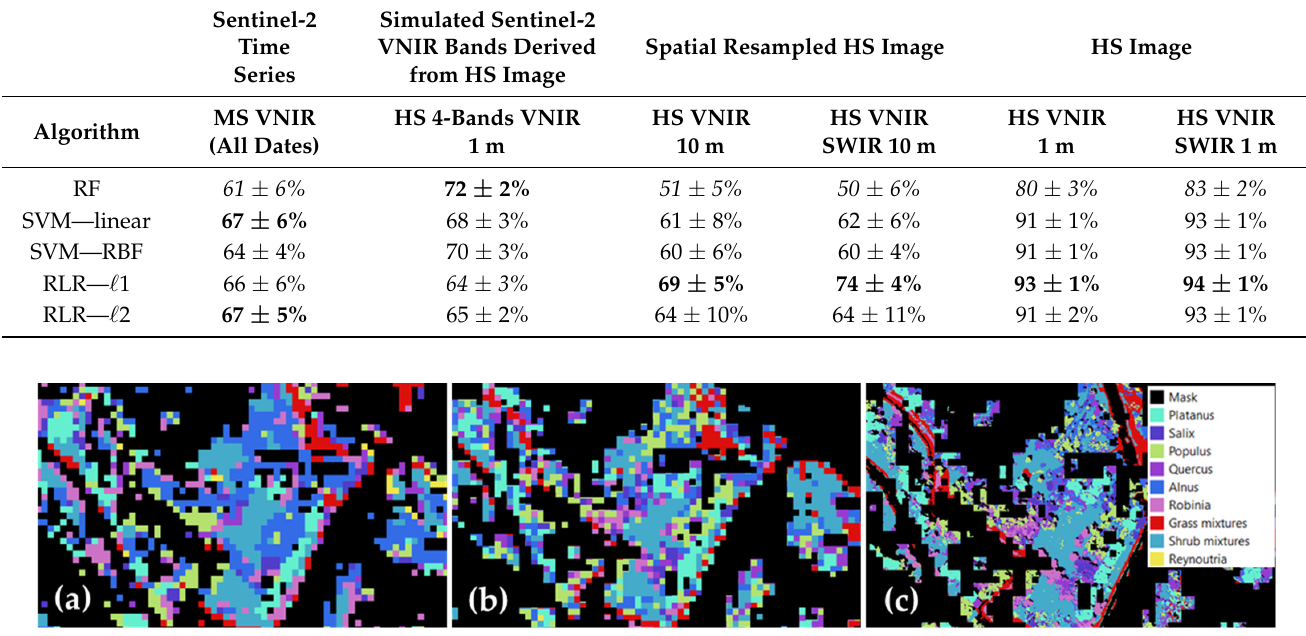
Table 8. Average Overall Accuracies (AOA) and corresponding standard deviations obtained with the different spectral and spatial configurations (MS: multispectral; HS: hyperspectral). The highest AOA is in bold and the lowest in italics.